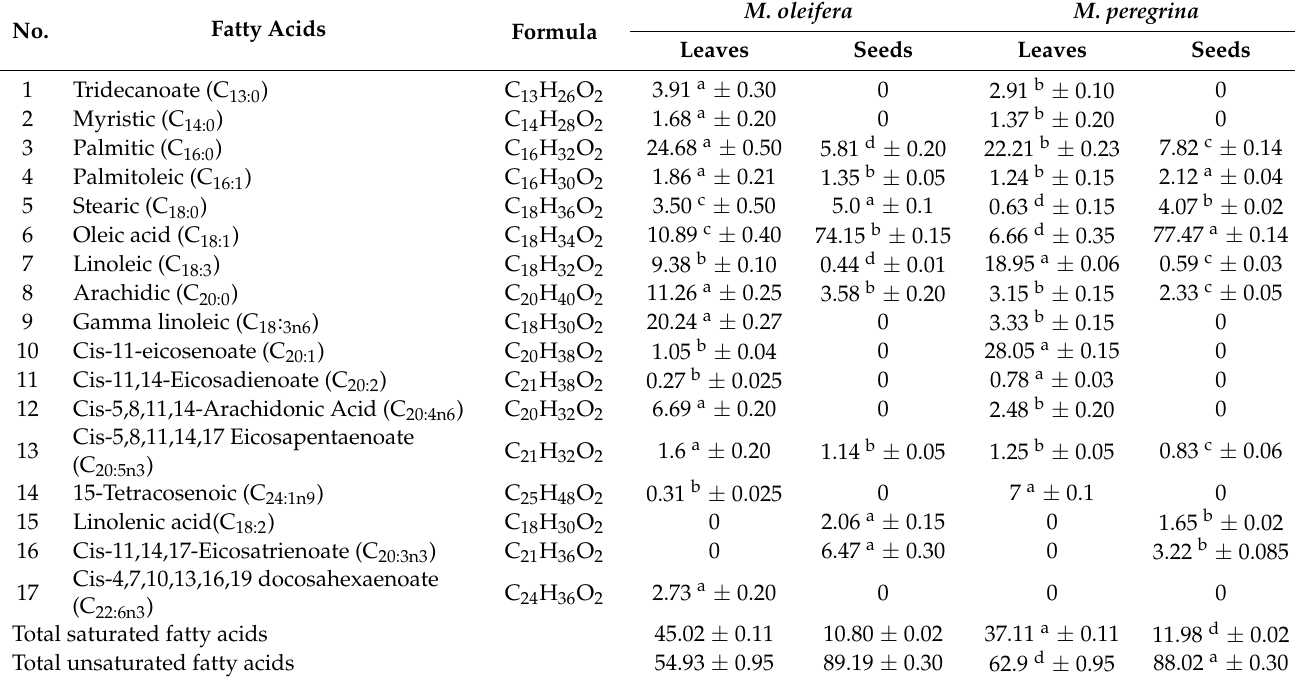
Table 2. Fatty acid composition (%) from leaves and seeds extracts of M. oleifera and M. peregrina